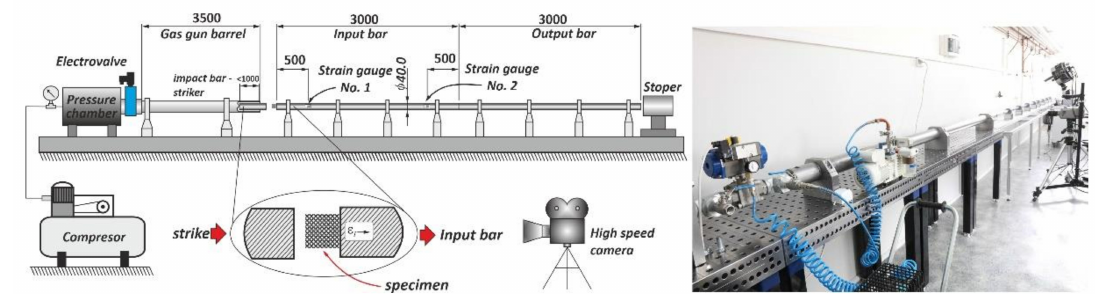
Figure 18. Scheme and main view of the Split Hopkinson pressure bar laboratory setup with the indirect configuration used to perform dynamic compression tests.